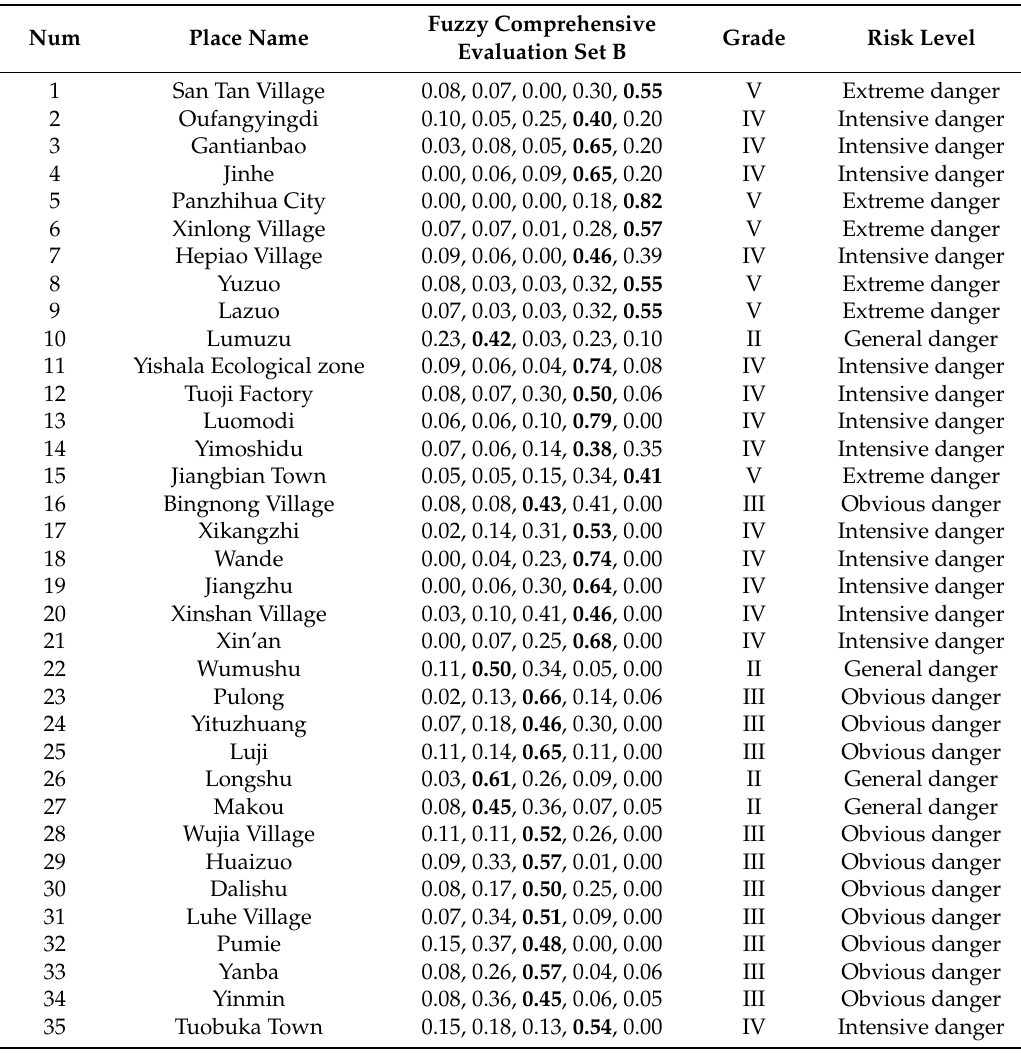
Table 9. The risk level of flood-affected